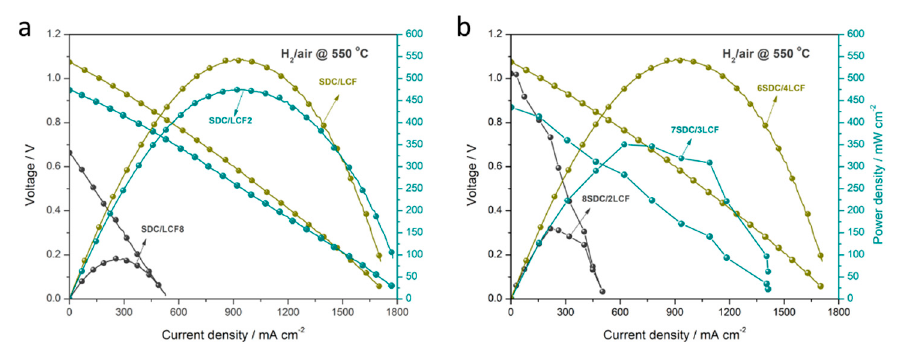
Figure 5. I–V and I–P characteristics of the fuel cell devices ( a ) using SDC/LCF2, SDC/LCF, and SDC/LCF8 composites in a weight ratio of 6:4 and ( b ) using various weight ratios of SDC and LCF